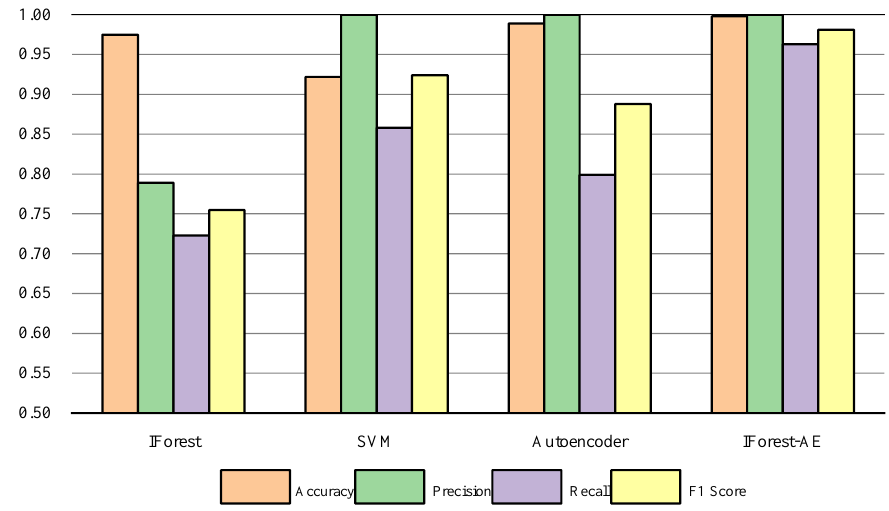
Figure 8. Comparison of different methods for anomaly detection.